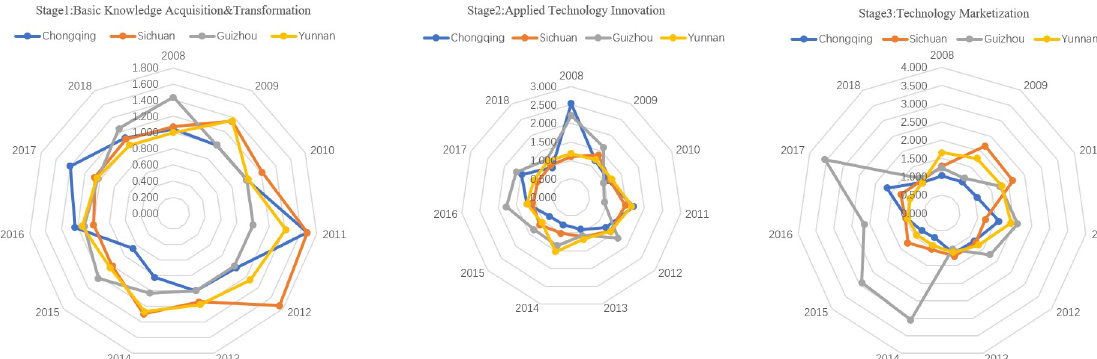
Fig 5. Efficiency of university technology marketization stage in Yangtze River Economic Belt.